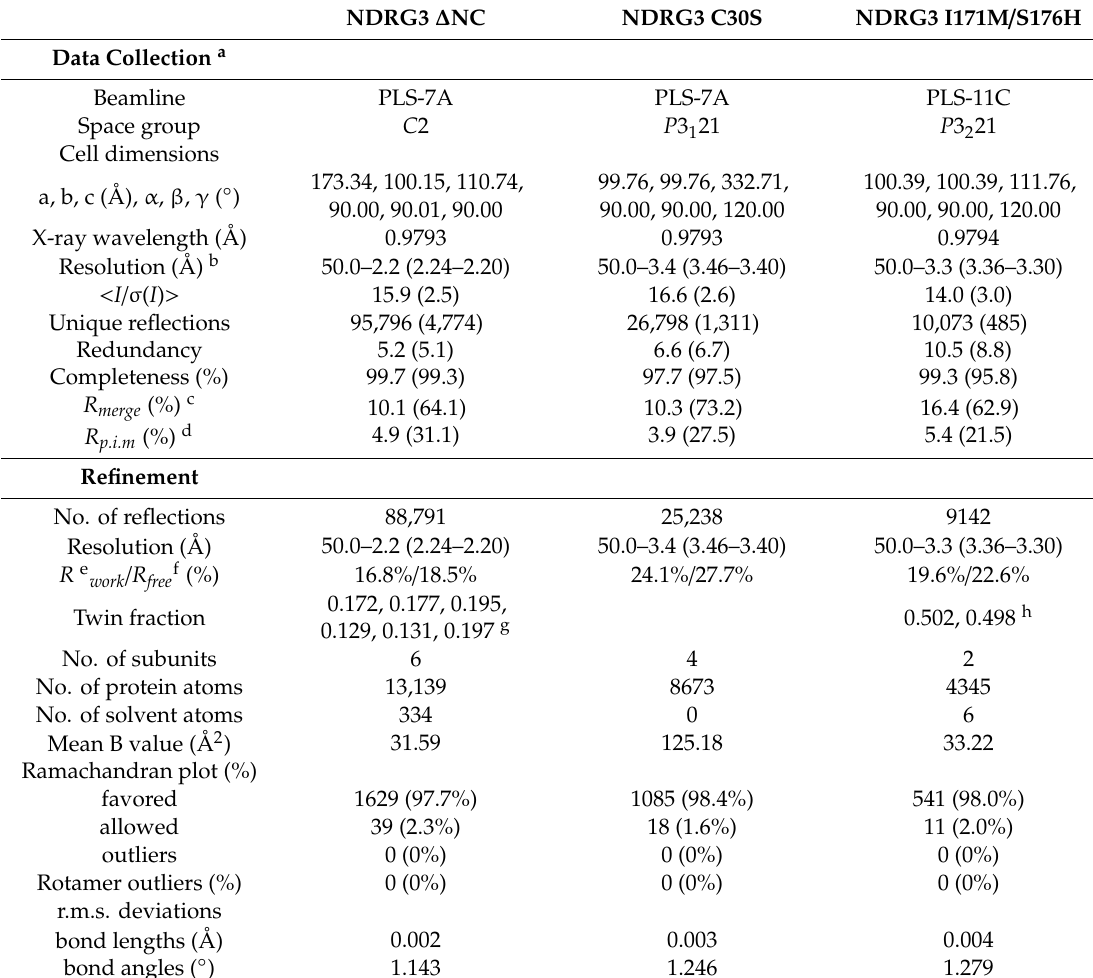
Table 1. Statistics for data collection and model